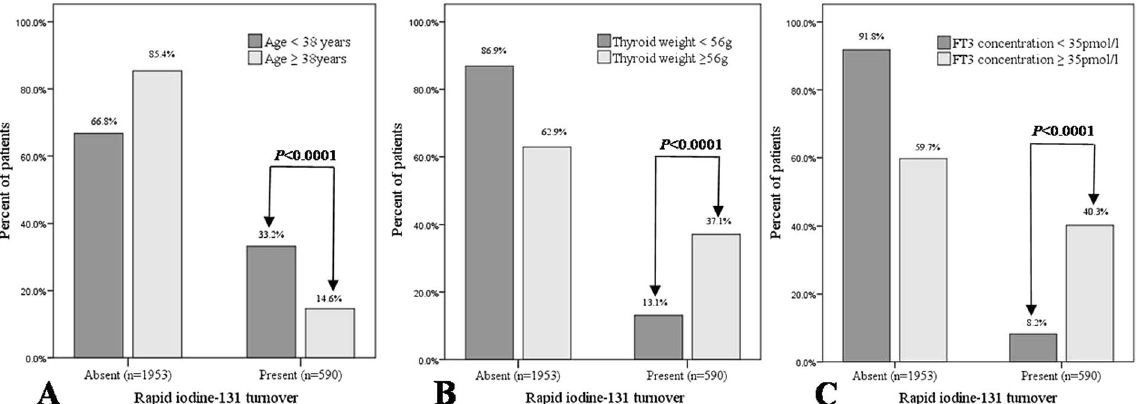
Figure 2. A comparative analysis of the percent of rapid 131 I turnover between the patients with age < 38 years or ≥ 38years ( A ), thyroid weight < 56 g or ≥ 56 g ( B ) and FT 3 concentration < 35 pmol/l or ≥ 35 pmol/l ( C